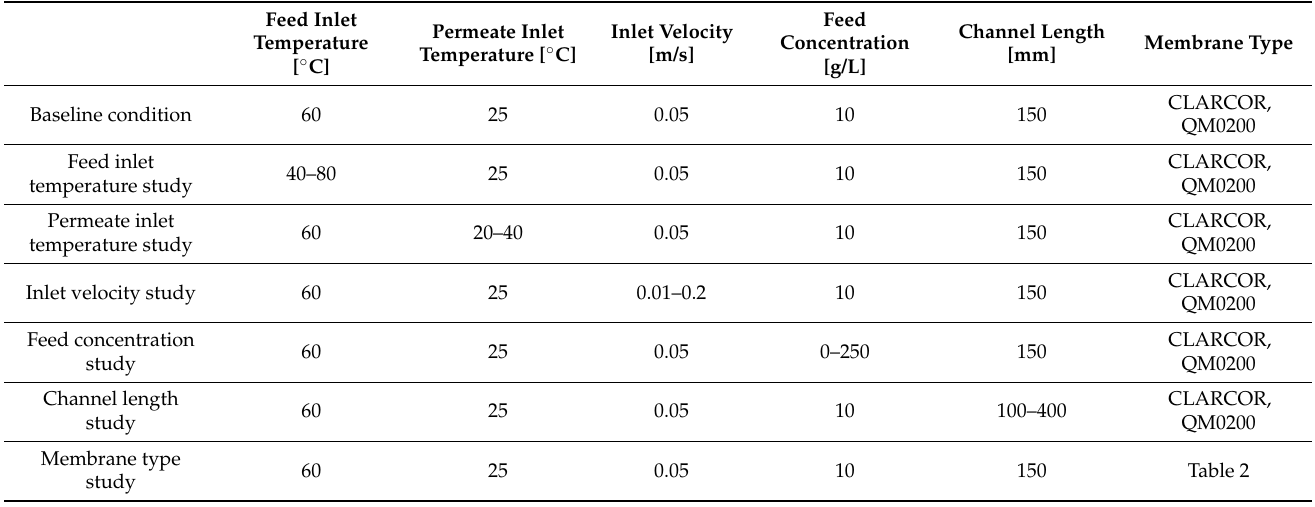
Table 1. Baseline and operating conditions for different parametric studies of a DCMD system.